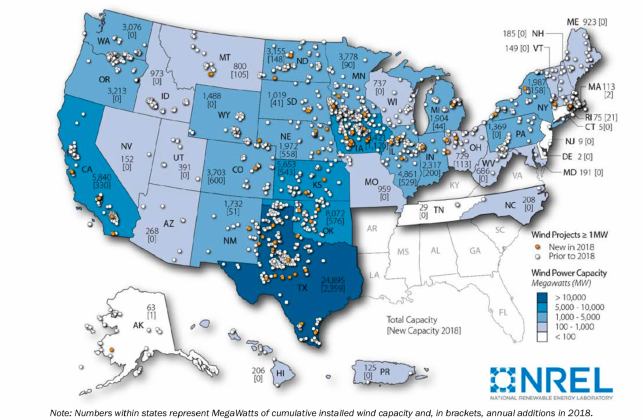
Figure 7. U.S. wind farms in 2018